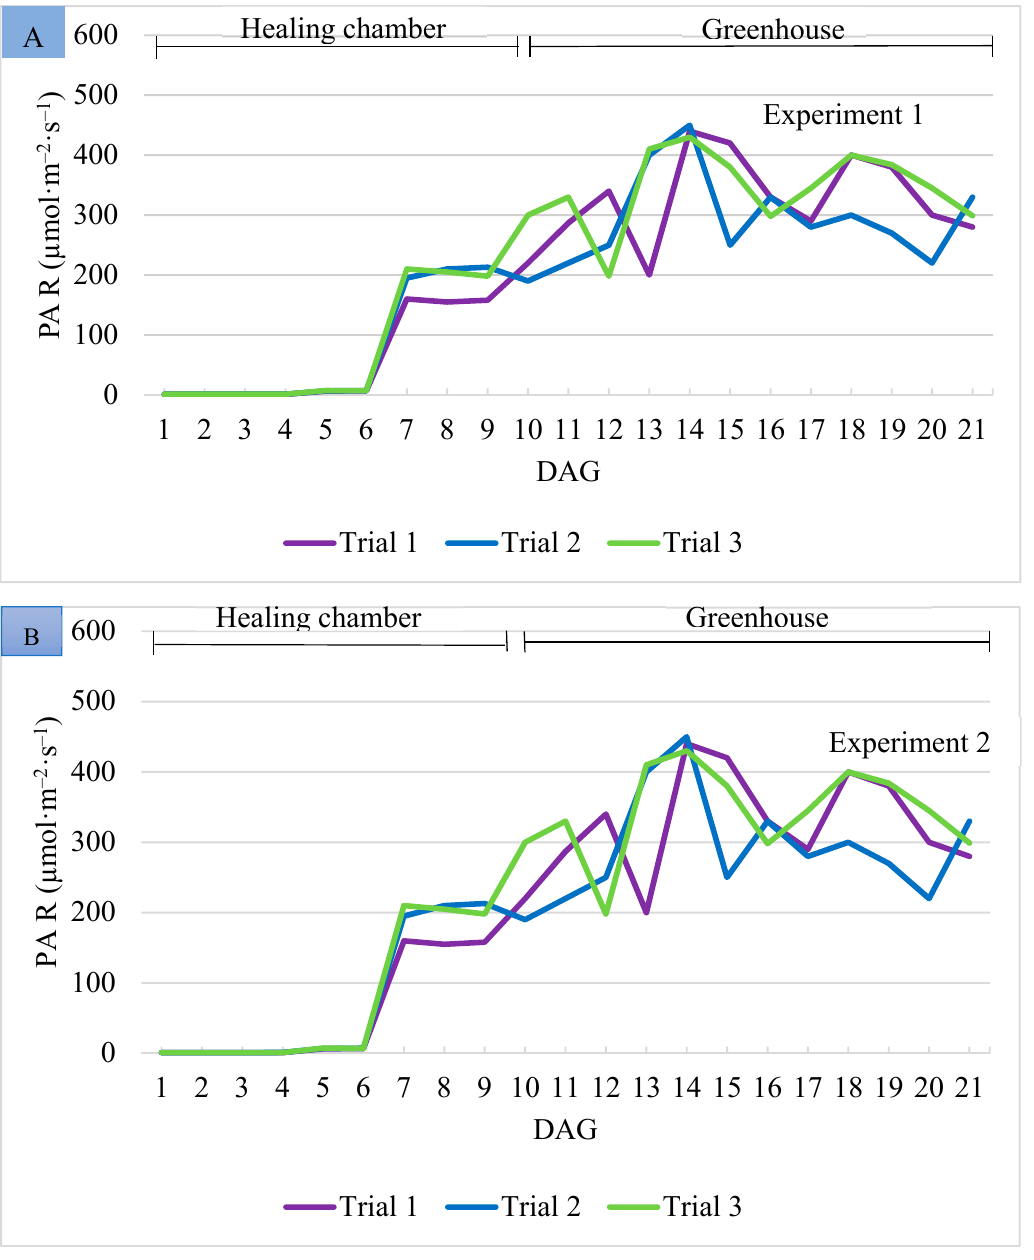
Figure 3. Light intensity of photosynthetically active radiation (PAR, µmol·m –2 ·s –1 ) in the healing chamber for 10 days after grafting (DAG) and in the greenhouse for 21 DAG for trials 1, 2, and 3 on 5 March, 15 March, and 23 April 2020, respectively, for experiment 1 ( A ), and for trials 1, 2, and 3 on 19 August, 14 October, and 10 November 2020, respectively, for experiment 2 ( B ) at Mount Vernon, WA, USA. Data were recorded every 15 min (Onset HOBO, Bourne, MA, USA).